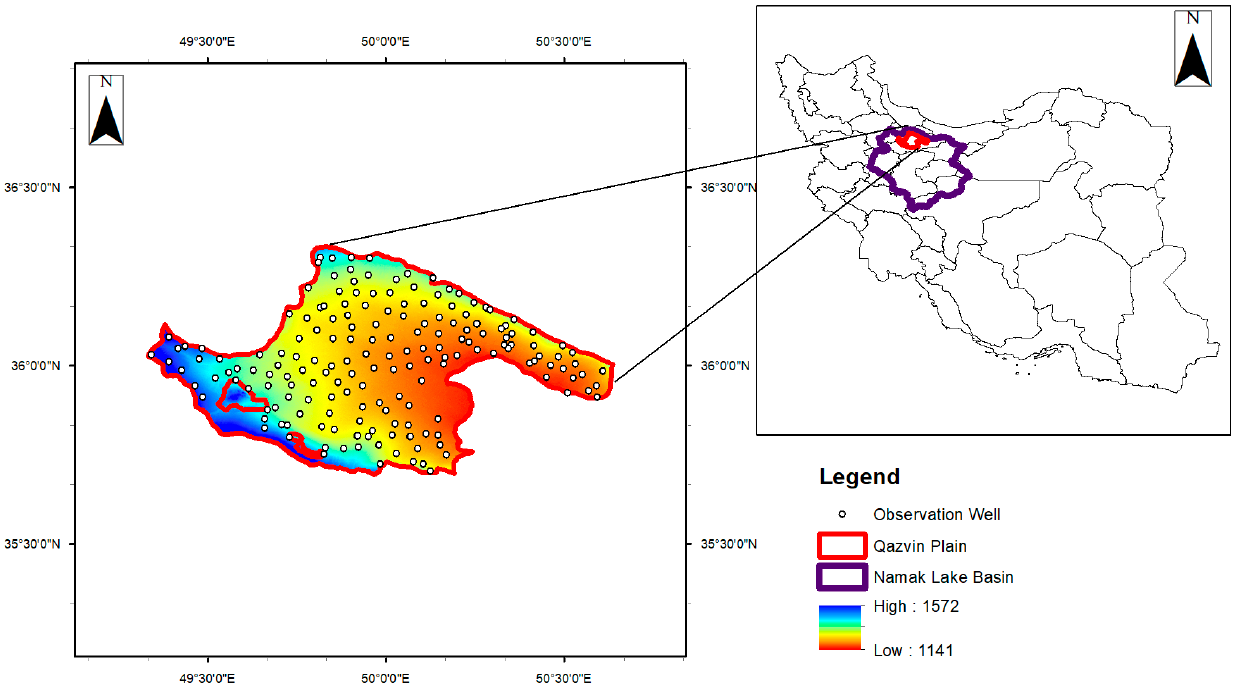
Figure 1. Study area and location of observation wells (shown with white small circles).